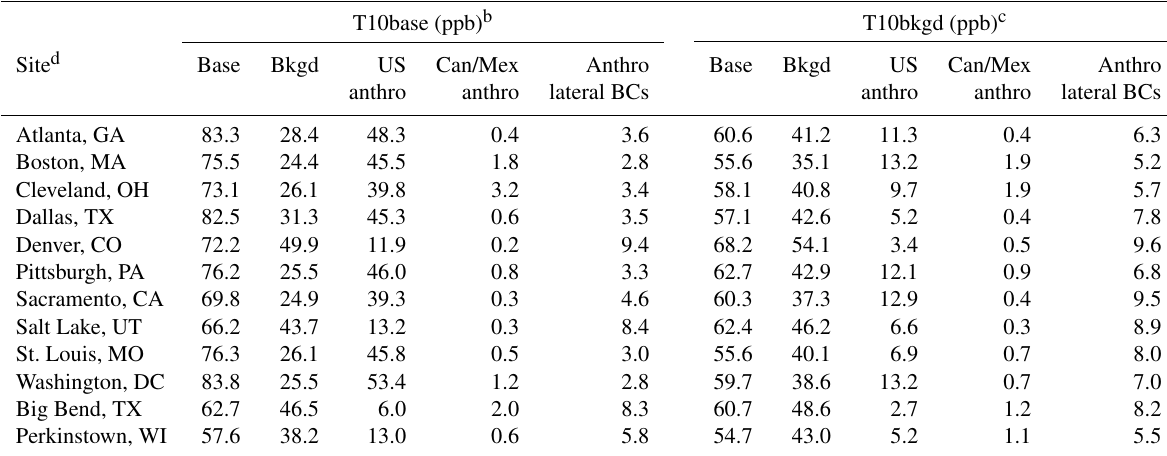
Table 3. Contributions of anthropogenic sources to the anthropogenic increment of MDA8 O 3 at AQS and CASTNet sites a .